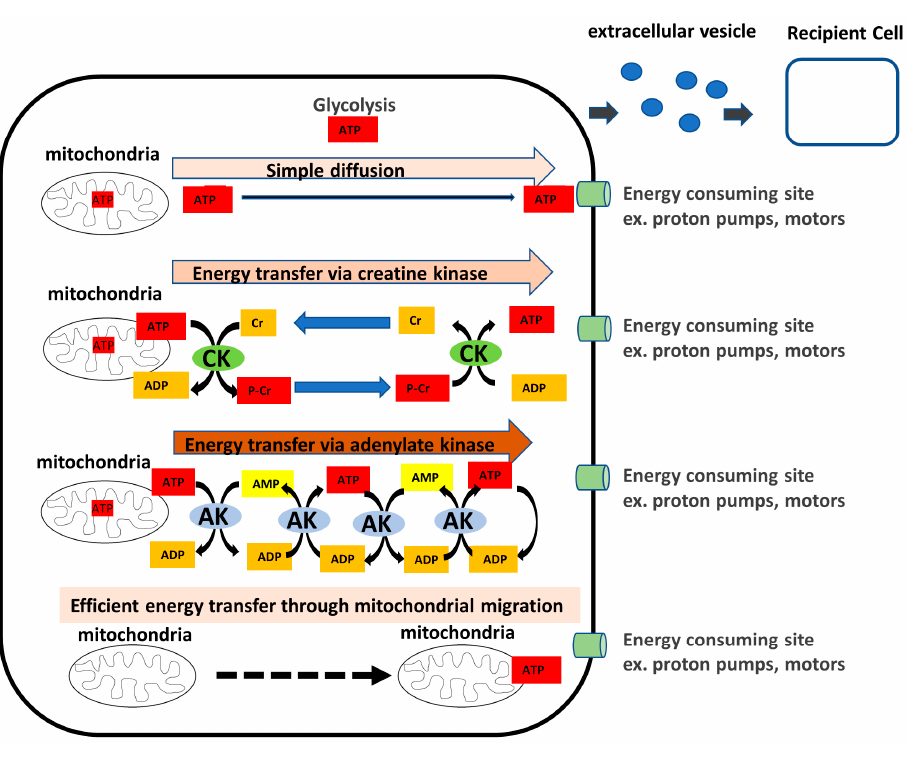
Figure 1. Model for high-energy phosphoryl transfer via adenylate kinase. As energy is transported from the mitochondria to the sites of utilization such as proton pumps or motors, the intracellular system supports an energy network of creatine kinase (CK), adenylate kinase (AK), and the localization or transport of the mitochondria themselves, in addition to simple diffusion. The presence of extracellular secretory AKs outside the cells suggests the existence of extracellular energy metabolism. In addition, intercellular energy networks, such as extracellular vesicles (EVs) are thought to exist.